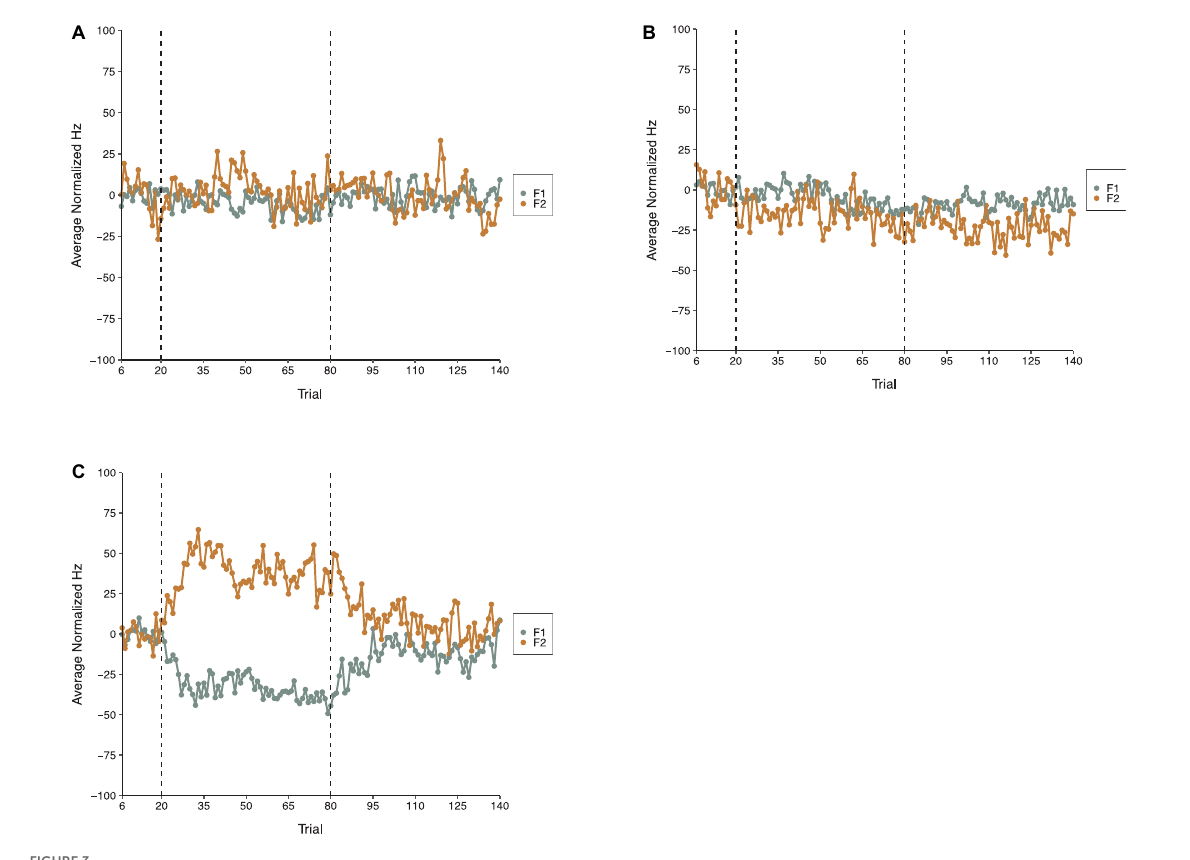
FIGURE3 Average normalized F1 (gray) and F2 (gold) speech production values from 18 speakers in the F1/F2 Random Perturbation Condition (A) , F1-Only Random Perturbation Condition (B) , and F1/F2 Coupled Random Perturbation Condition (C) of Experiment 1. From left to right, the dotted lines denote boundaries between the Baseline, Perturbation, and Return phases, respectively.